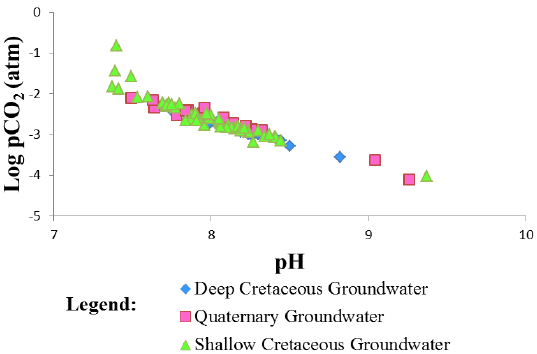
Figure 9. Geochemical relationship of pH vs. log ( p CO 2 ) in